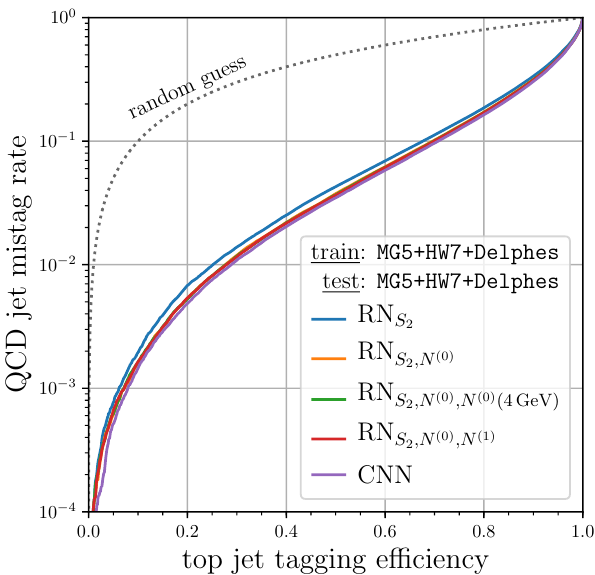
Figure 19. The ROC curves of the networks trained on HW7 samples.